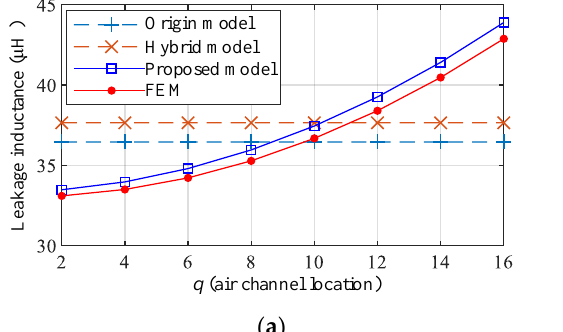
Figure 10. Comparison of FEM and analytical calculation results. ( a ) Comparison of results, ( b ) Comparison of errors.